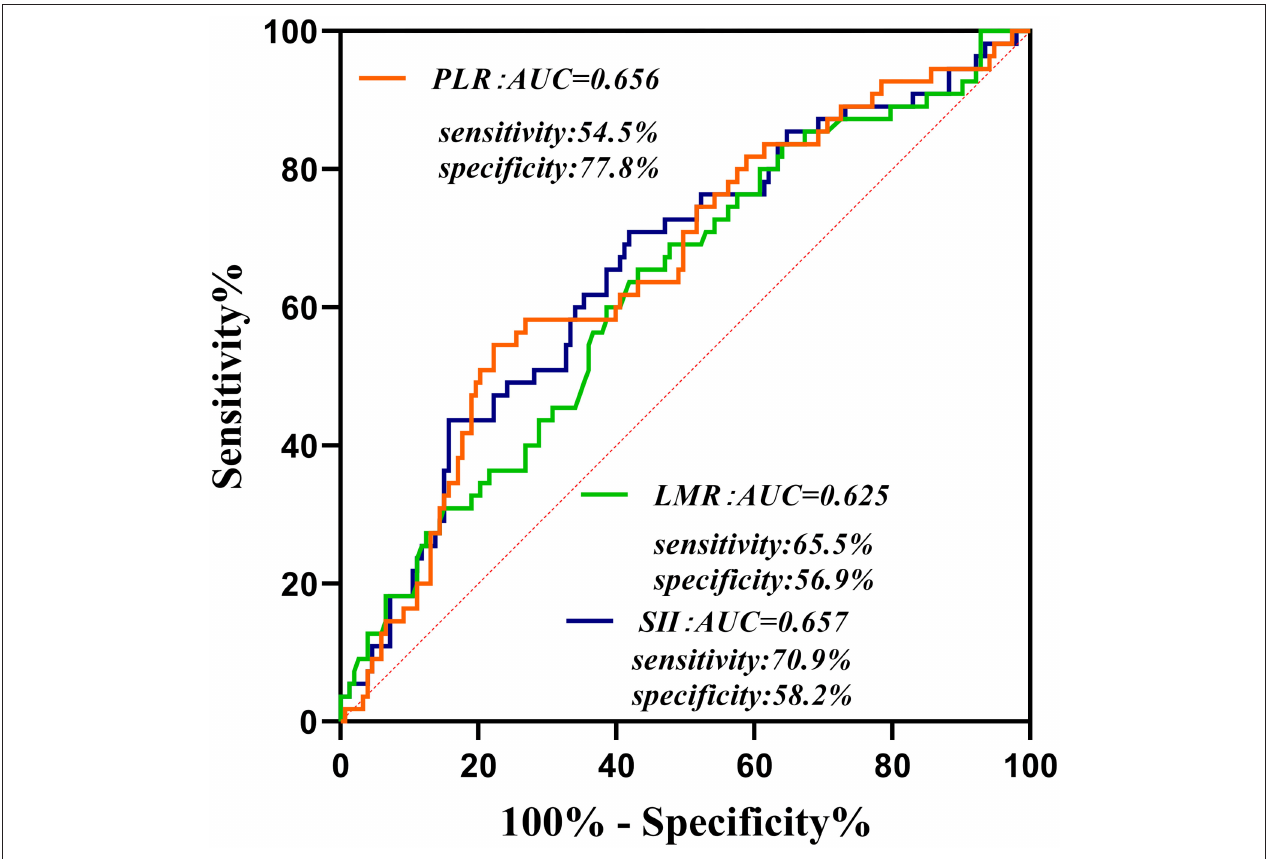
FIGURE 2 | Receiver operating characteristic curve for composite inflammatory ratios (systemic immune inflammatory index, platelet to lymphocyte ratio, and lymphocyte to monocyte ratio) to predict the risk of adverse outcomes in patients with AIS. AUC, area under the curve; SII, systemic immune inflammatory index; PLR, platelet to lymphocyte ratio; LMR, lymphocyte to monocyte ratio.